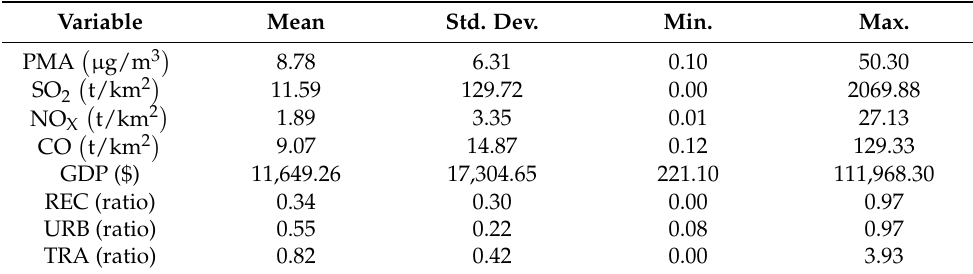
Table 1. Descriptive Statistics of Variables.